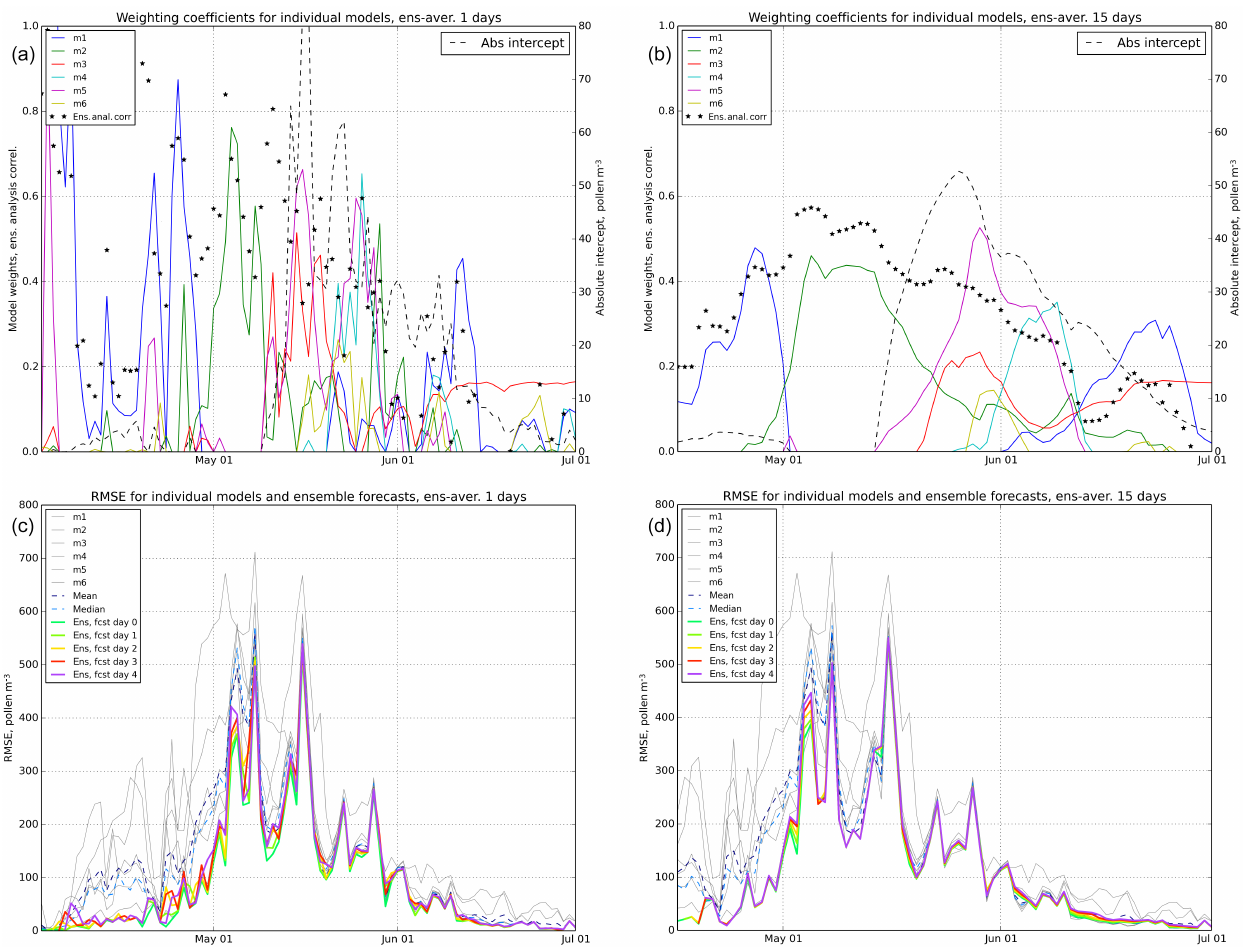
Figure 12. Sensitivity of optimised ensemble to the length of assimilation window. Upper row: optimal weights of the individual models and ensemble score over the 1- (a) and 15- (b) day-long assimilation windows; lower row: RMSE of the of individual models and the optimal ensemble forecasts against those of individual models. Note different time axes. Forecasts are available earlier for the 1-day analysis